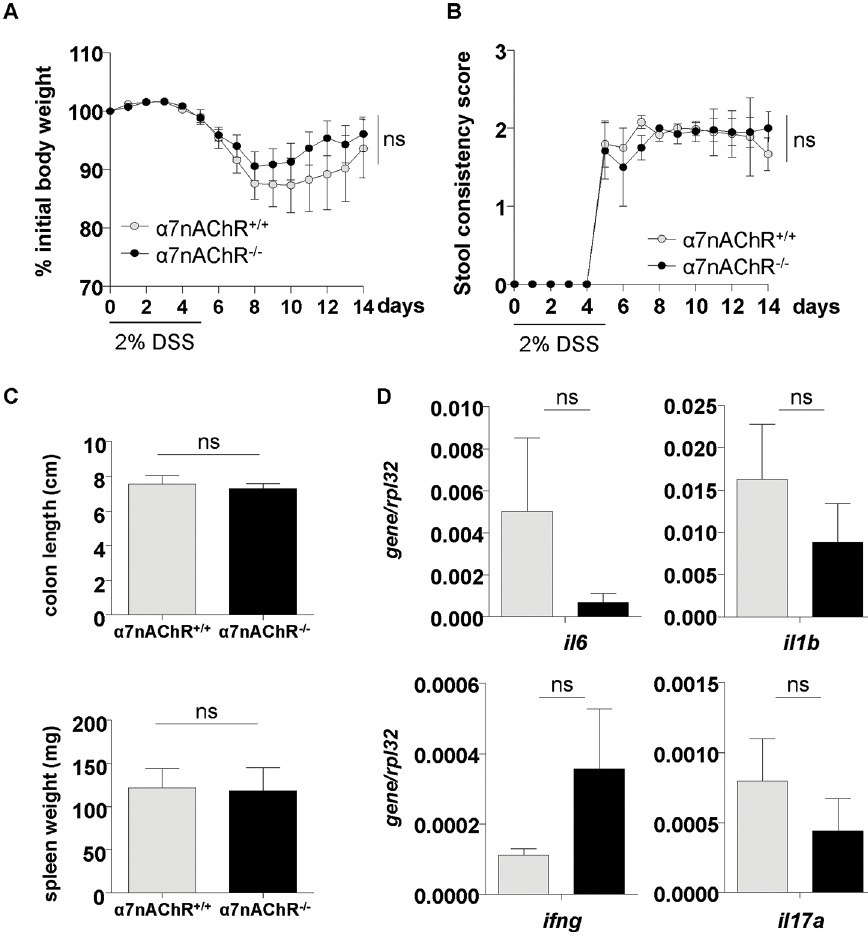
Figure 5. α 7nAChR expression does not influence the severity of acute DSS colitis. α 7nAChR -/- and α 7nAChR +/+ mice were subjected to DSS-colitis. (A) Body weight and (B) stool consistency were scored daily. Statistical significance was determined using a multivariate linear model after a post-hoc Bonferroni-Holm correction for body weight changes and stool consistency score (ns, not significant). (C) Fourteen days after DSS treatment, mice were sacrificed to measure colon length and spleen weight. (D) In- flammatory gene expression was quantified via q-PCR in colonic tissue. Gene expression levels are shown relative to rpl32 mRNA expression. Data expressed as mean ± SEM, are representative of three independent experiments. Statistical significance was determined with the unpaired Student t -test for colon length, spleen weight, gene expression level and flow cytometry analysis (ns, not